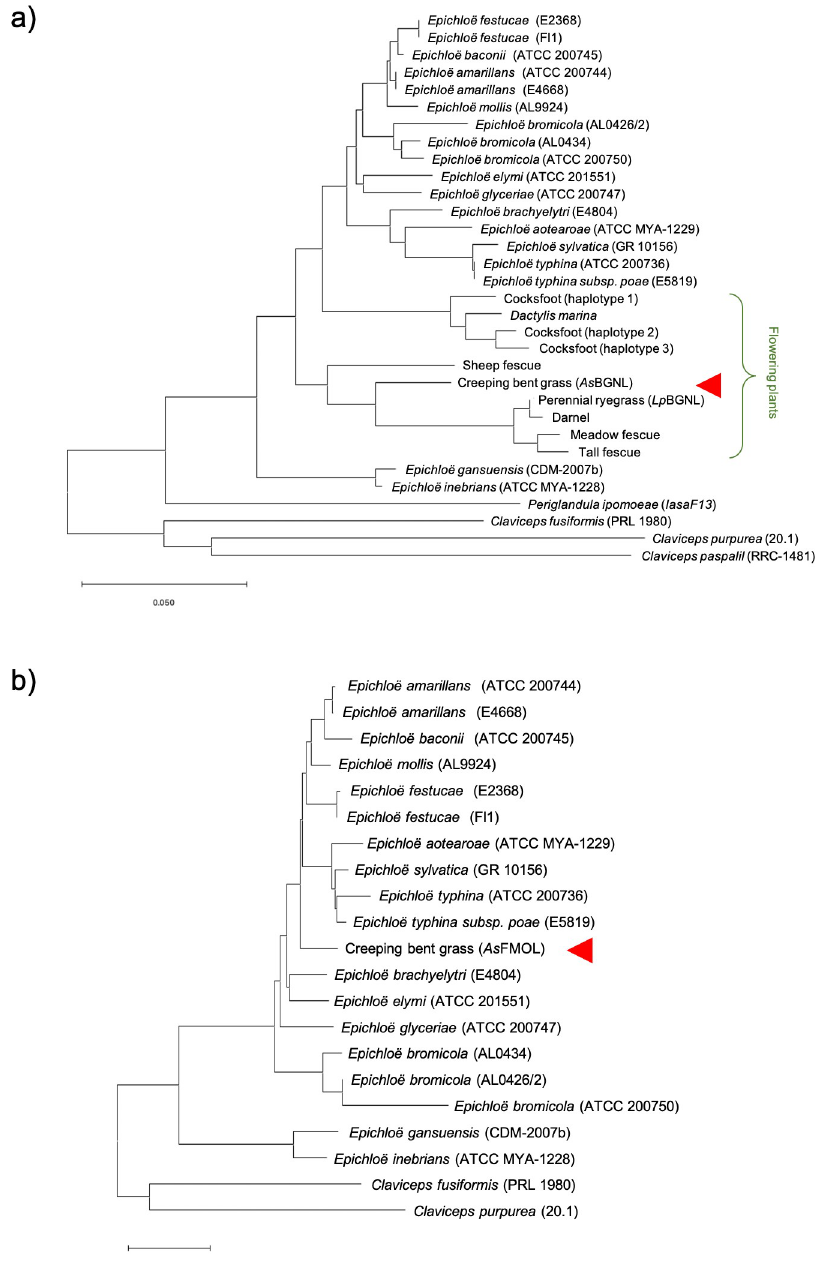
Fig 4. Phylogenetic analysis for the HGT candidates. (a) Phylogenetic tree of plant and fungal ß-1,6-glucanase(-like) genes, based on an amino acid alignment of the aryl-phospho-beta-D-glucosidase domain. (b) Phylogenetic tree of plant and fungal FMO-like genes on an amino acid alignment. Sequences from creeping bent grass are indicated with red arrows. Strain identifiers of the Genome Project at the University of Kentucky website or NCBI UI are shown in